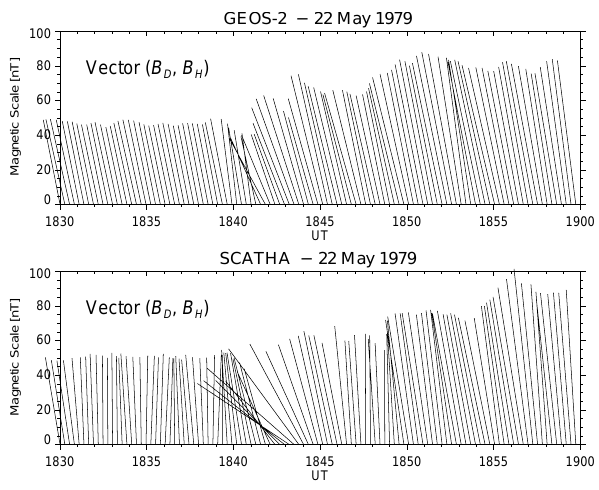
Fig. 10. Vector plots of the magnetic field normal to the meridian plane, B H vs. B D , for GEOS-2 and SCATHA as functions of